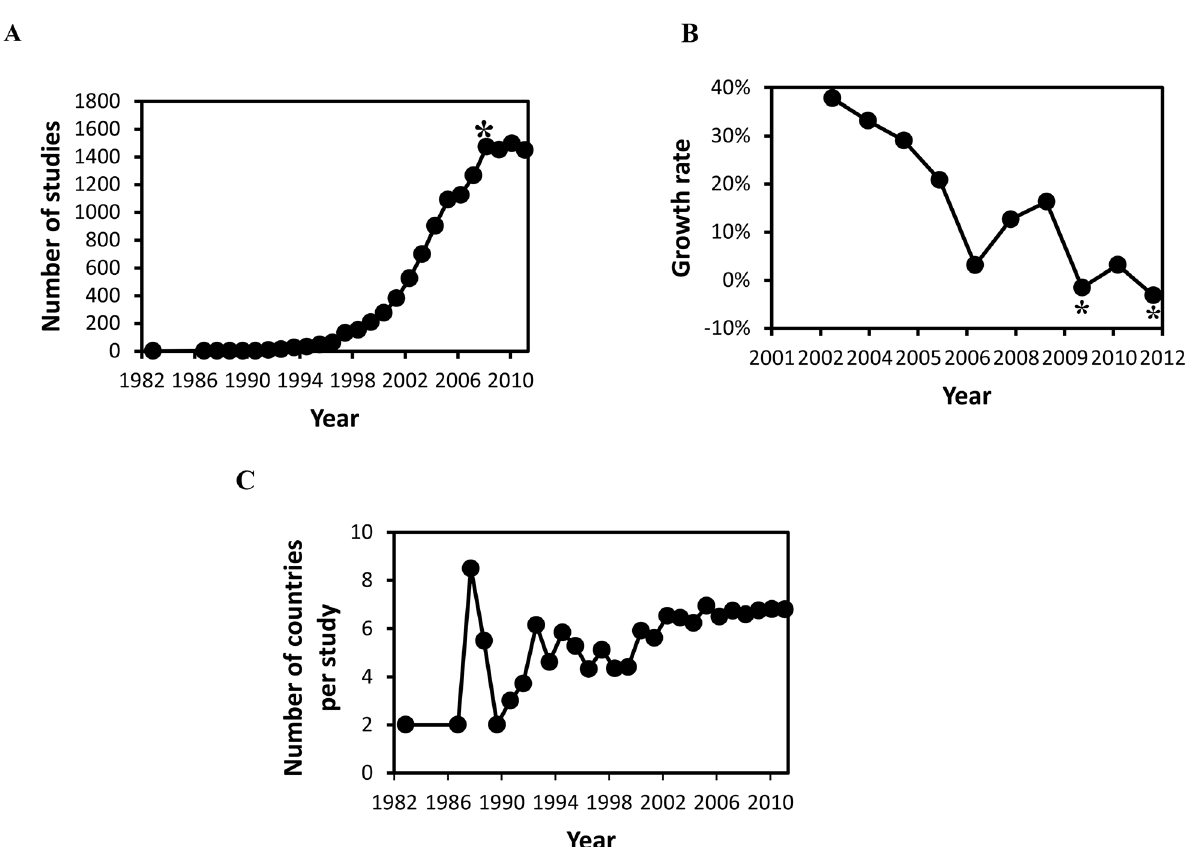
Fig. 2. Historical trends in multinational studies registered at ClinicalTrials.gov. ( A ) Number of multinational studies per year. The asterisk (*) indicates the peak in growth in 2009. ( B ) Year-over-year growth in the number of multinational studies for the period 2003–2012. The asterisks (*) indicate years that had negative growth. ( C ) Average number of countries per multinational study for the period 1982–2012.